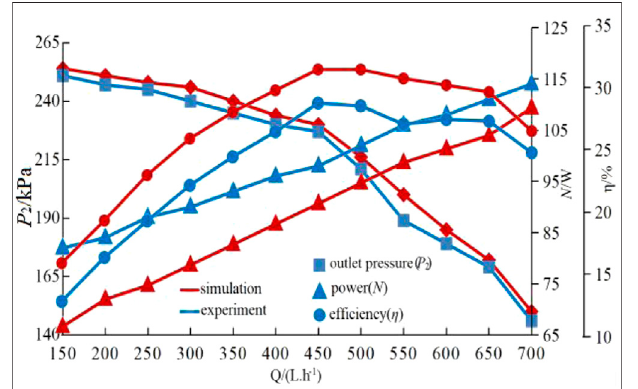
FIGURE 6 | Performance curves under different working conditions.